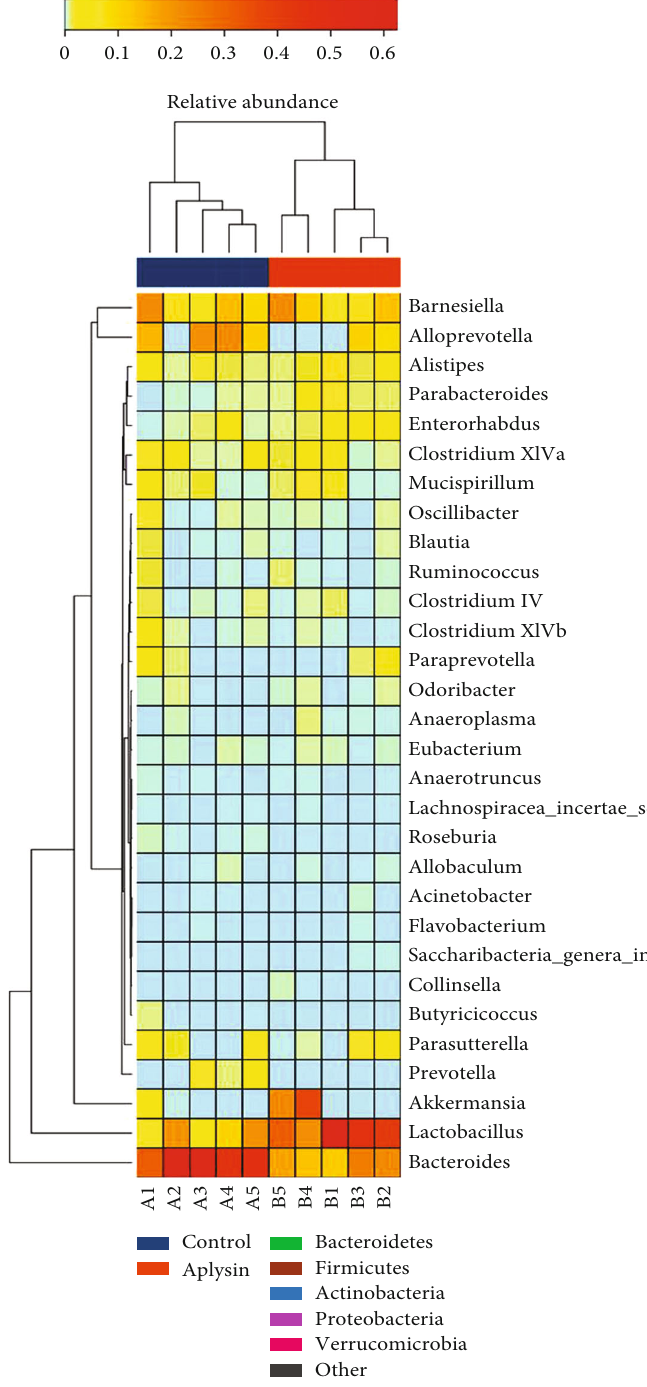
Figure 9: Heat map comparison at the genus level (top enriched 30 genus) of intestinal fl ora in each sample. The phylogenetic relationships, clustering analysis, and the phylum to which each genus belonged in both groups are